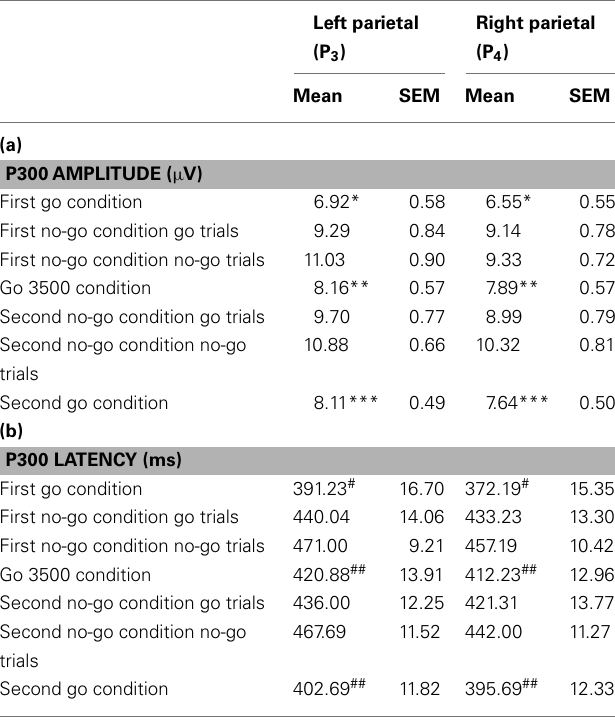
Table 2 | Parietal P300 amplitudes (a) and latencies (b) observed during the conditions of the